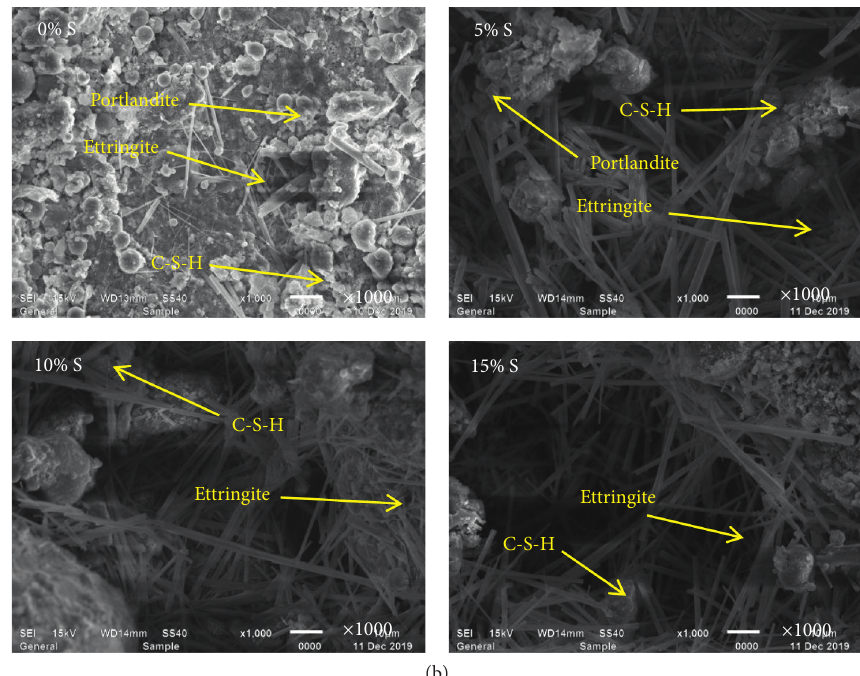
Figure 9: SEM images of CGFB samples immersed in 0–15% sodium sulfate solutions at the (a) third and (b) fifteenth drying-wetting